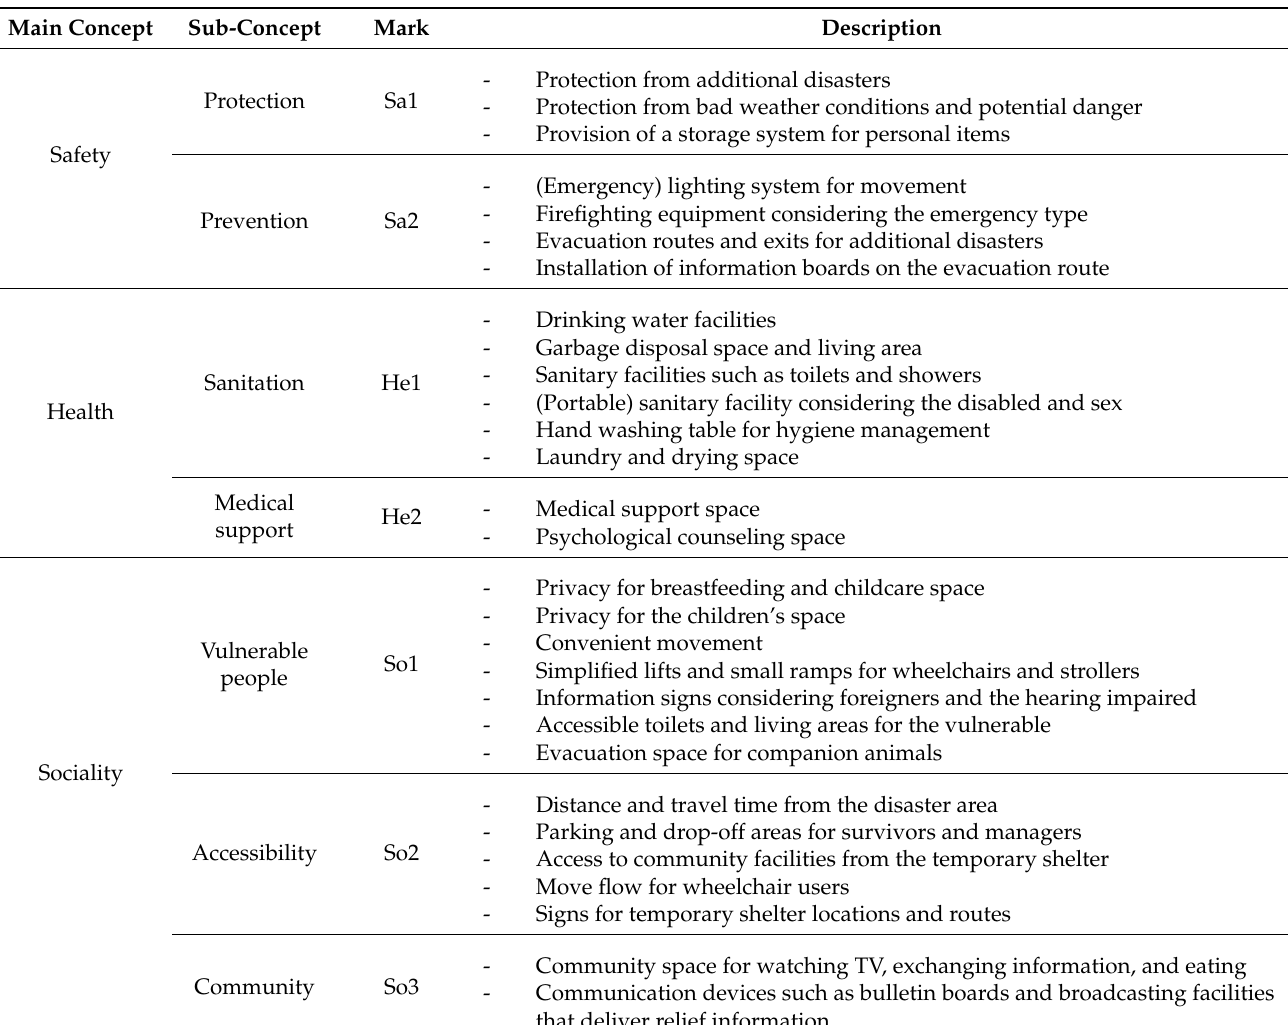
Table 1. Critical concepts of habitability in temporary shelters for disaster